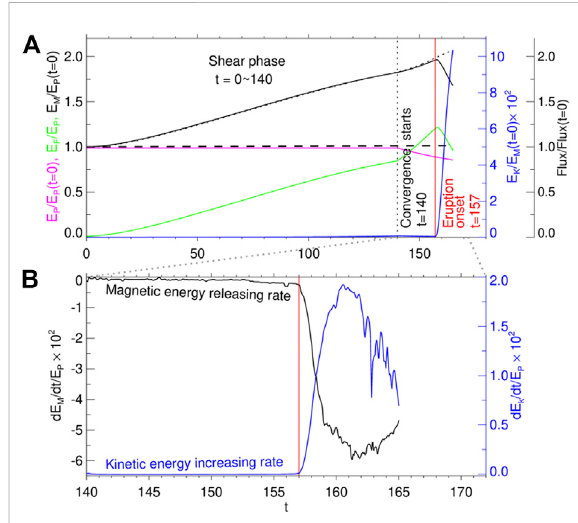
FIGURE 4 Temporalevolutionofmagneticenergies,kineticenergy,and magnetic fl ux in the simulation. (A) Evolution of total magnetic energy E M (black), free magnetic energy E F (green), potential magnetic energy E P (magenta), kinetic energy E K (blue line), and magnetic fl ux (black dashed line). The dotted curverepresents theenergyinjectedintothefullvolumefromthebottomboundary through the surface fl ow. The vertical black dotted line denotes the beginning of the converging fl ow, and the vertical red line denotes the transition time from pre-eruption to eruption. (B) Magnetic energy releasing rate (black line) and the kinetic energy increasing rate (blue line).